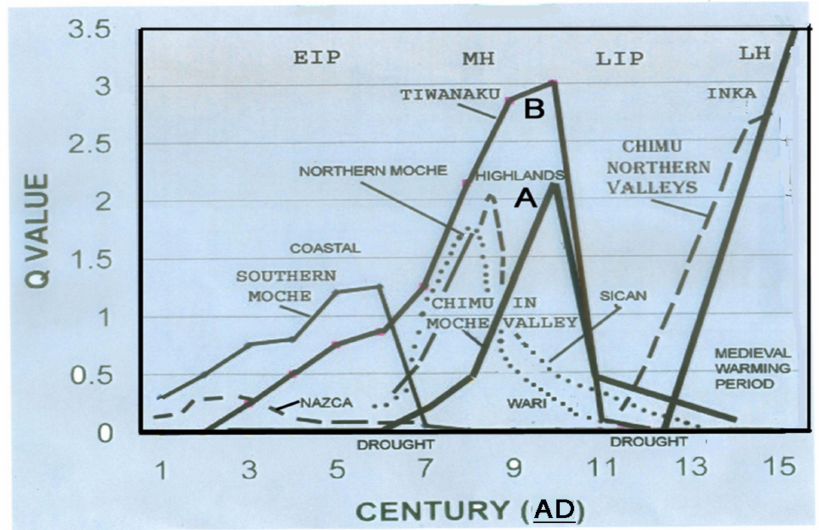
Figure 17. The AD 10–11th century drought led to societal decline for both the highland Tiwanaku and Wari polities as well as for Peruvian north coast societies. Occurrences of El Niño, La Niña and other ENSO climate change e ff ects on continuity of major Andean societies constitute a vital part of understanding Andean